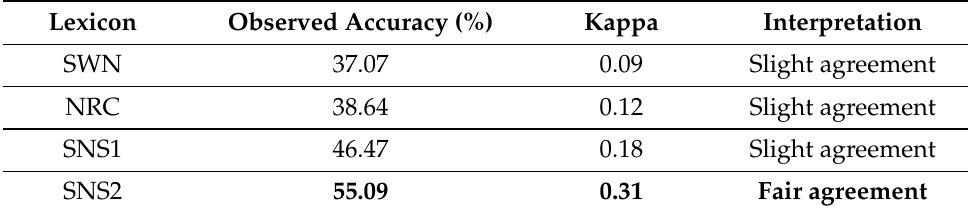
Table 5. Observed accuracy and kappa statistic.